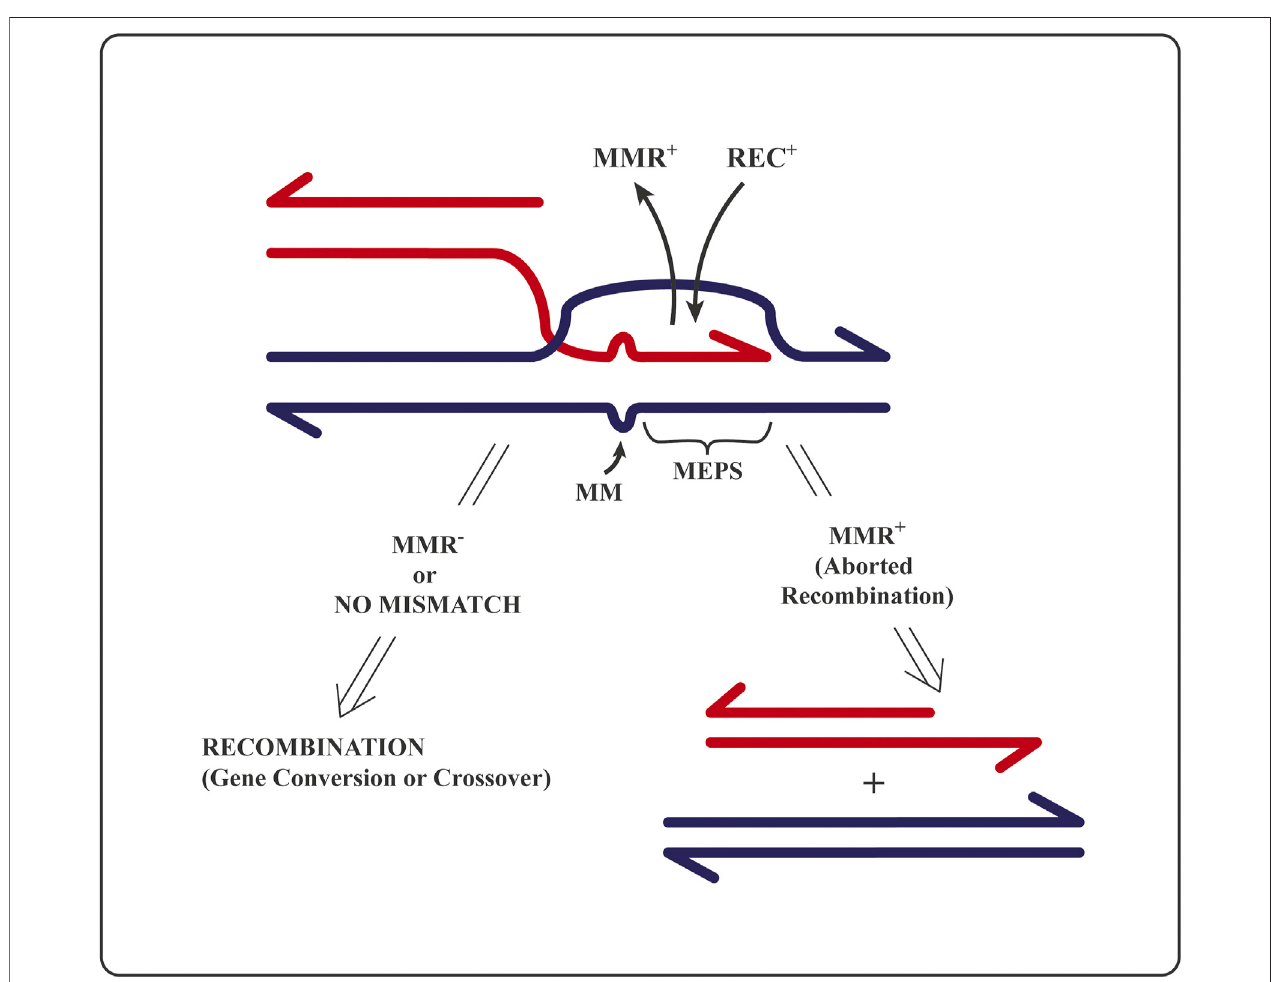
FIGURE 2 | A drawing of the mechanistic principle for the editing of homologous recombination by mismatch repair proteins: Reversal of an attempt to initiate homologous recombination between non-identical (homeologous) sequences. MMR + stands for mismatch recognition and repair proteins; REC + for recombination proteins at the DNA strand invasion step; MM are mismatched or unmatched bases; MEPS is “ minimal ef fi cient processing segment ” , i.e., minimal suf fi cient block of strict sequence identity required to initiate strand exchange (ref 13). RecBCD nuclease is known to degrade the free-ended (red) DNA that did not succeed in recombination ( Š tambuk and Radman, 1998) precluding repeated recombination attempts at the already edited site. See text and refs. (Shen and Huang, 1986; Radman, 1989; Kowalczykowski et al., 1994; Worth et al., 1994; Š tambuk and Radman, 1998; Wiktor et al., 2021).